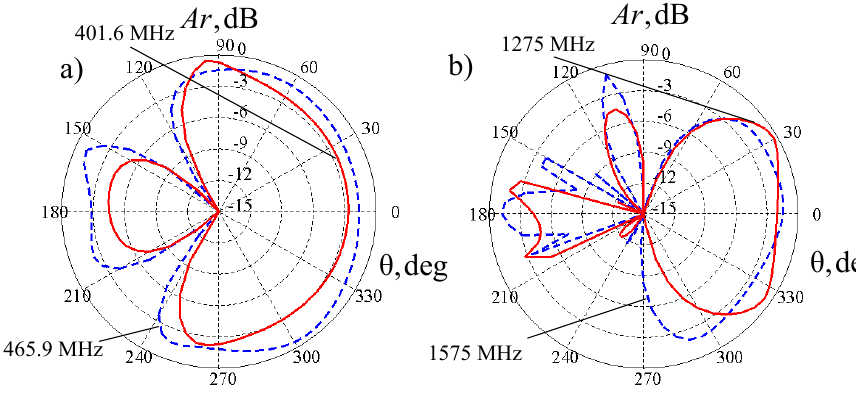
Fig. 3. Radiation pattern of the combined antenna at Argos-3 band (a) and GPS L1+L2 band (b) for right-handed (RHC) and left-handed (LHC) polarizations.